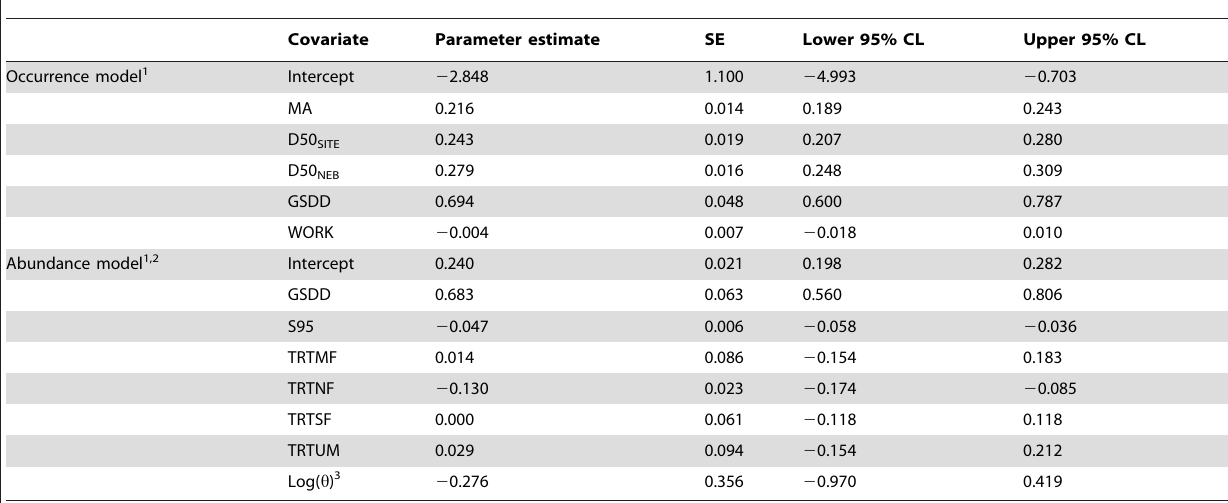
Table 3. Standardized model-averaged parameter estimates, unconditional SE values, and 95% confidence limits (CLs) for covariates predicting the occurrence (binomial model) and abundance (count model) of steelhead redds in the John Day River basin,